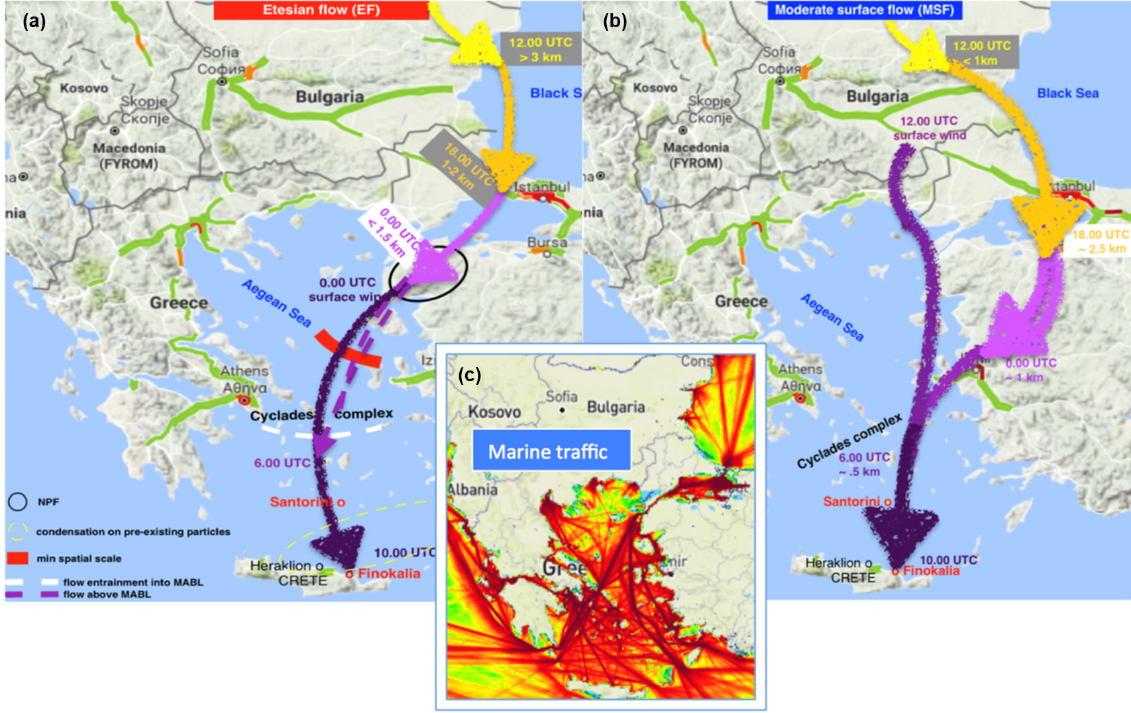
Figure 1. The extended area of study where the major routes (arrows) of air masses pass through Santorini and Finokalia on 23 July (EF – left panel) and 26 July (MSF – right panel) is indicated. In the left panel, the areas of NPF (black ellipse), the spatial extent of NPF event (red line), flow entrainment into MABL (white dashed line), and the condensation (yellow dashed ellipse) are shown. The major traffic (green) and urban (red) emission sources are also shown. The marine traffic is shown in the middle